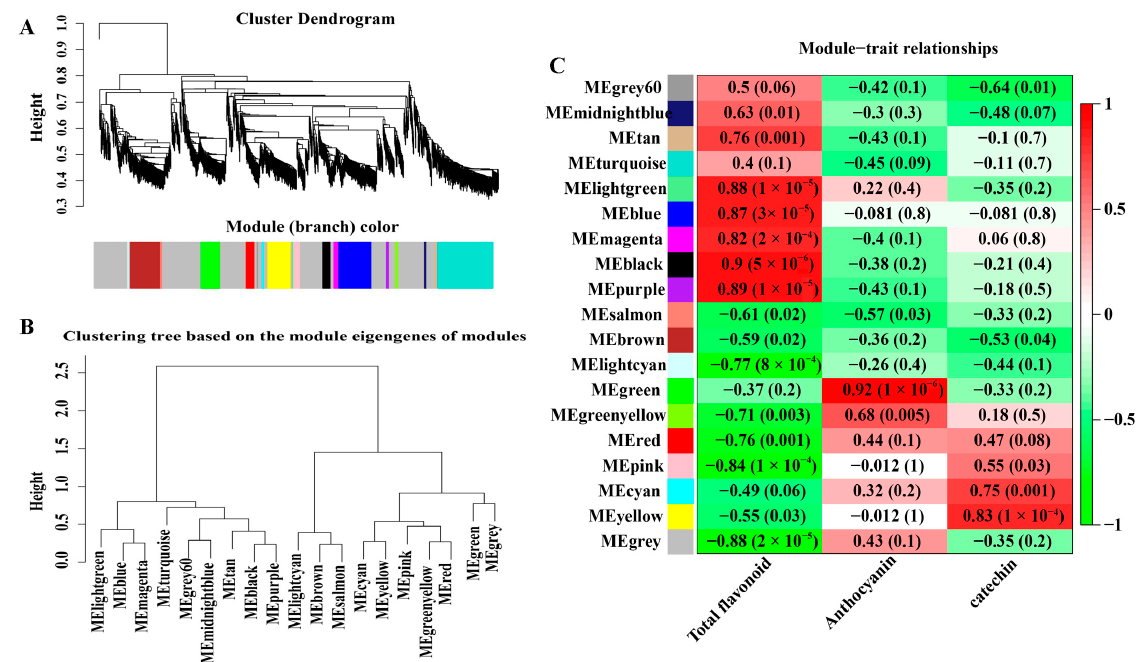
Figure 5. Weighted gene co-expression network analysis (WGCNA) of DEGs related to the flavonoid. ( A ) Gene dendrogram obtained by clustering the dissimilarity is based on consensus topological overlap with the corresponding module colors indicated by the color row. Each colored row represents a color-coded module that contains a group of highly connected genes. ( B ) WGCNA obtains a dendrogram of consensus module eigengenes on the consensus correlation. The black line is the merging threshold, and groups of eigengenes below the threshold represent modules whose expression profiles are merged due to their similarity. ( C ) A heatmap plot of consensus module eigengenes and flavonoid, anthocyanin, and catechin content. The module type is on the left side. Numbers in the table report the corresponding module eigengenes and tissue correlations, with P values printed in the bracket. The table is color-coded by correlation according to the color legend. The intensity and direction of correlations are indicated on the right side of the heatmap (red, positively correlated; green, negatively correlated).